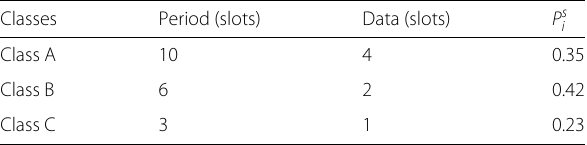
Table 3 Parameters of nine IoT